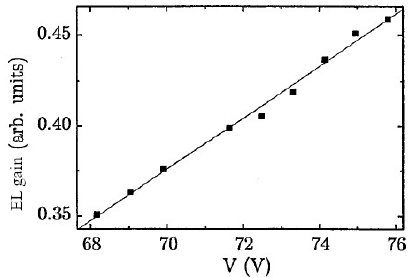
Figure 27. Proportional EL gain of needle-type device in liquid Xe as a function of the applied voltage [80]. The electric field near the tip of needle varies from 30 × 10 3 kV/cm to 2 × 10 3 kV/cm over distance of 0.1 μ m. If to extrapolate to zero, light emission has a threshold at 44 V.